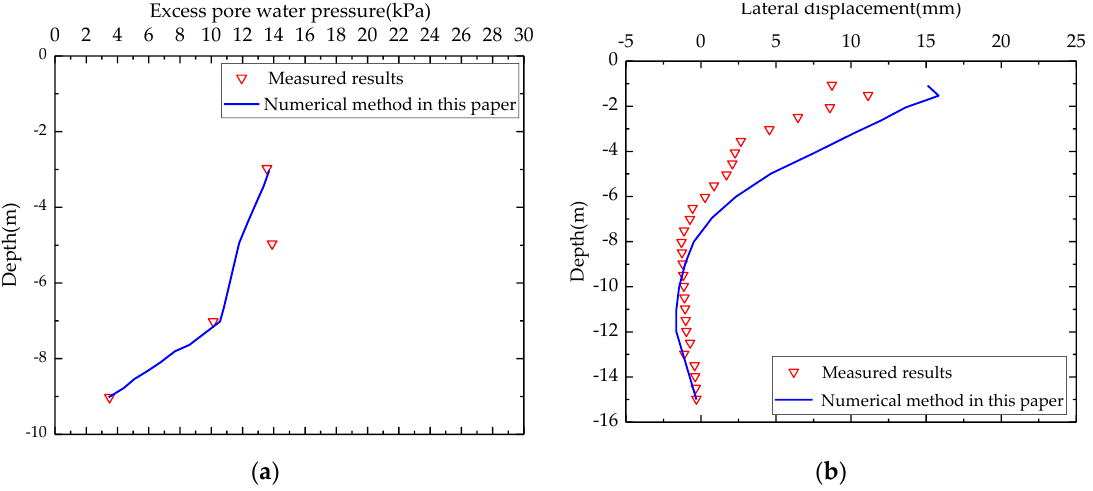
Figure 3. Comparison with the field results for the case of 1500 kN·m tamping energy. ( a ) Excess pore water pressure versus soil depth; ( b ) Lateral displacement versus soil depth.